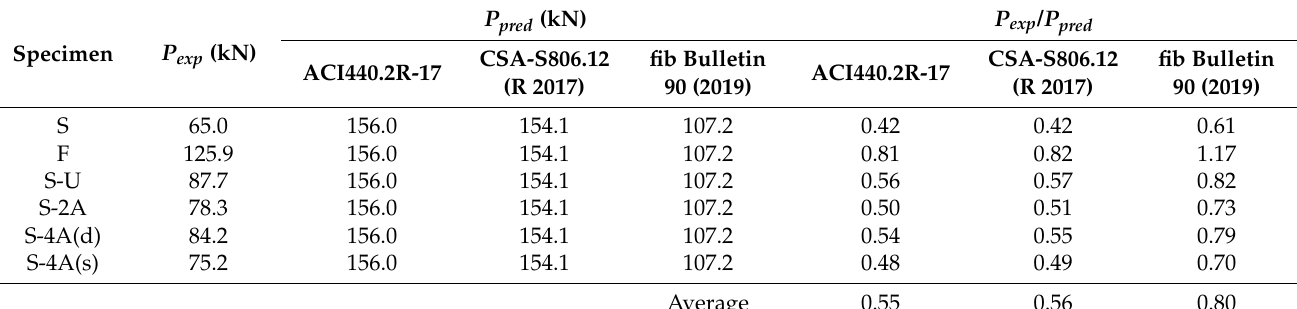
Table 6. Ultimate load